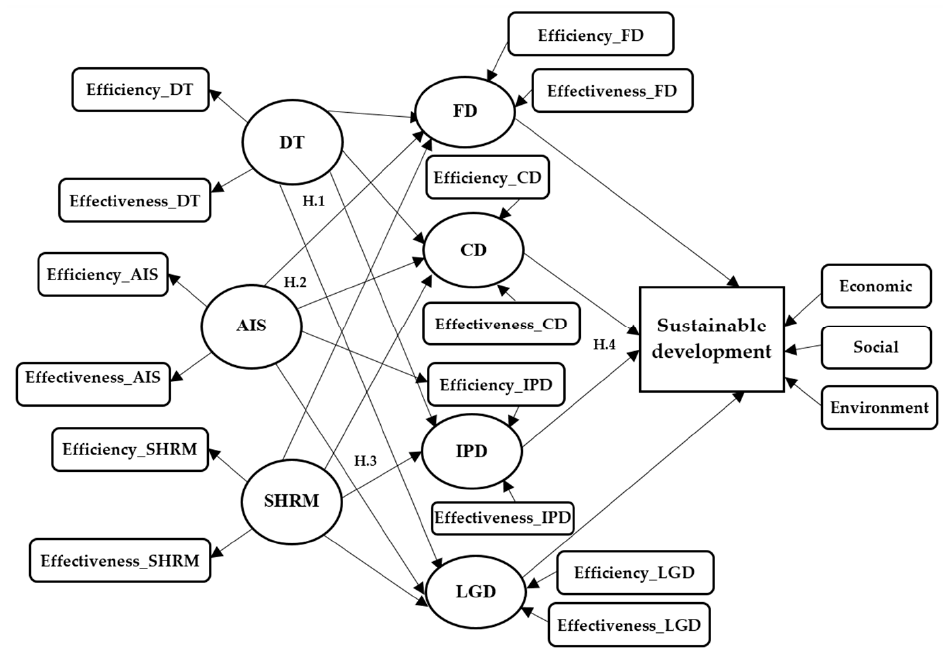
Figure 1. Theoretical model. Source: own construction based on [7,9,31,42,106,107].